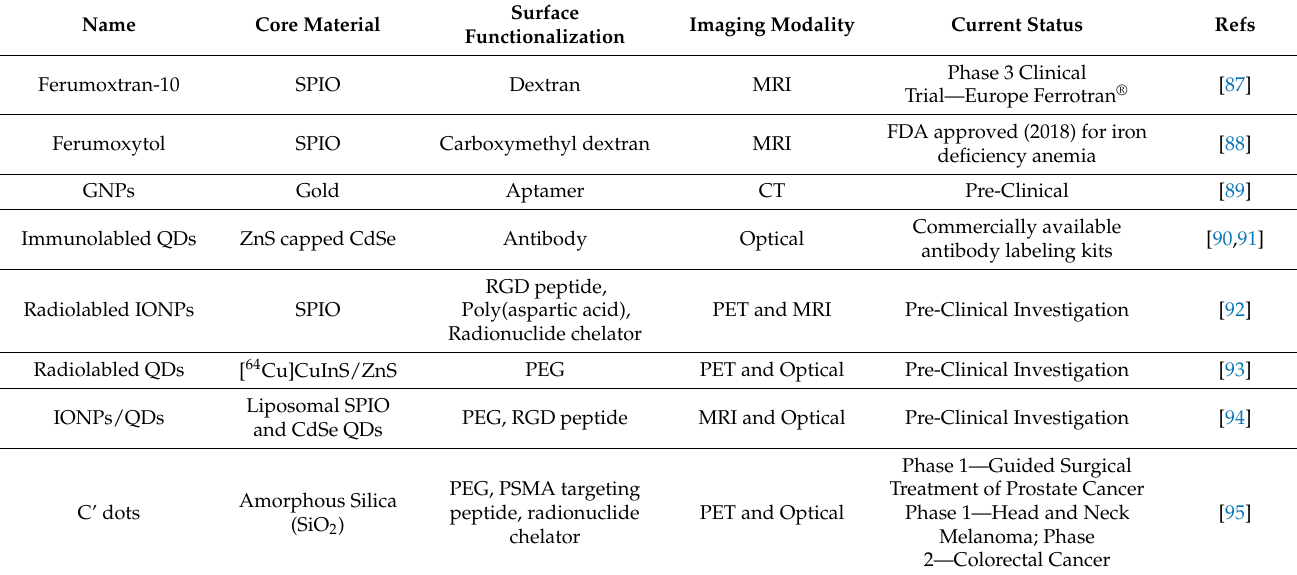
Table 1. Nanoparticles developed for prostate cancer (PCa) bone metastasis